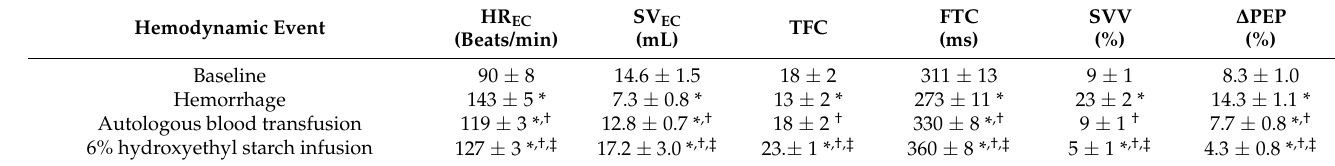
Table 2. Mean ± SD for heart rate, stroke volume, thoracic fluid content, flow time corrected, stroke volume variation, and variation in pre-ejection period measurements recorded using electrical cardiometry (HR EC , SV EC , TFC, FTC, SVV, and ∆ PEP) in six healthy, isoflurane-anesthetized Beagle dogs during four hemodynamic events: (1) baseline; (2) withdrawal of 30 mL/kg blood volume inducing hemorrhage; (3) autologous blood transfusion; and (4) 20 mL/kg 6% hydroxyethyl starch 130/0.4 in 0.9% sodium chloride solution. Since the values for HR EC , SV EC , TFC, FTC, SVV, and ∆ PEP for the five timepoints under each event are not statistically significant, the mean ± SD values are calculated from the timepoint measurements to represent each event.